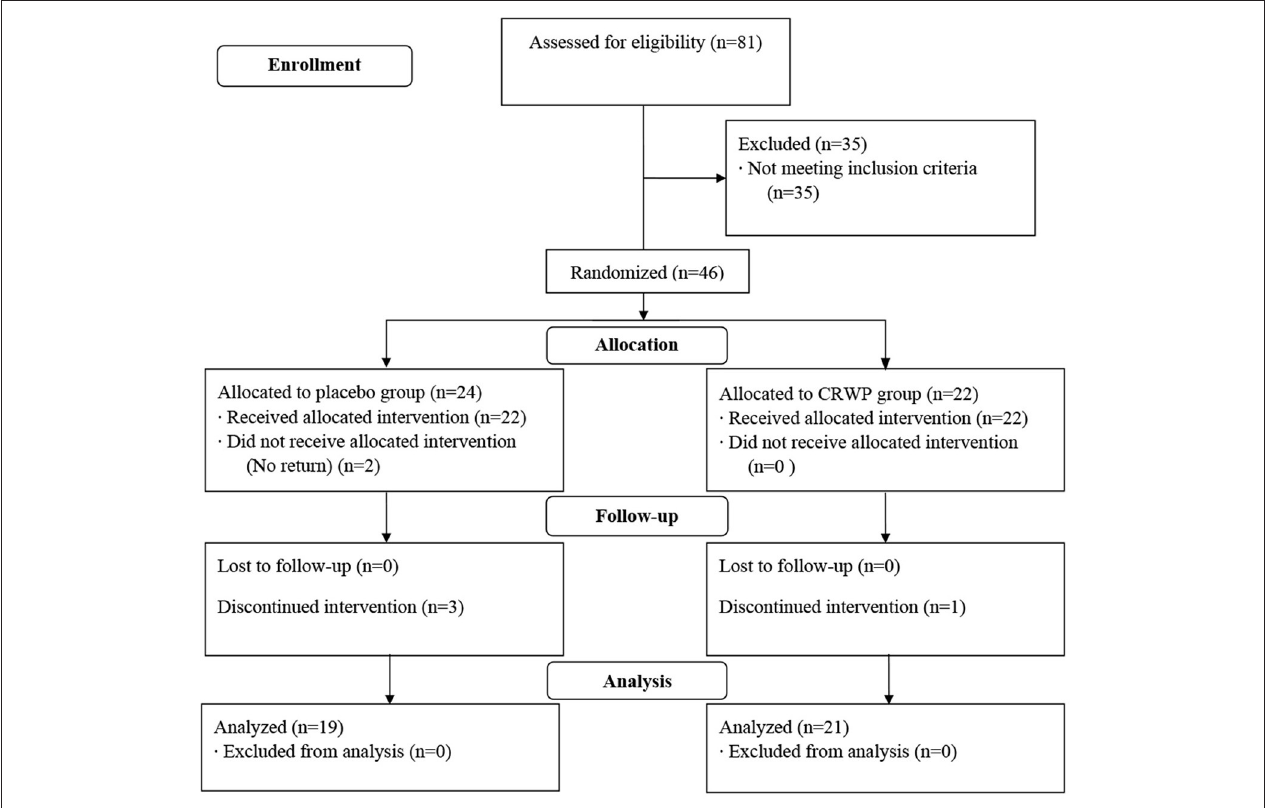
FIGURE 2 | Flow chart of study participant disposition.